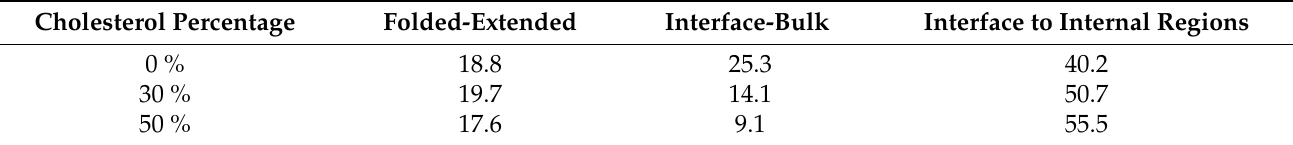
Table 3. Free energy barriers ∆ F (in kJ/mol) for the main transitions of a DMPC-bound MEL. Folded to extended corresponds to transitions between basins A and B or between C and D. Internal regions correspond to z ∼ 0. Cholesterol Percentage